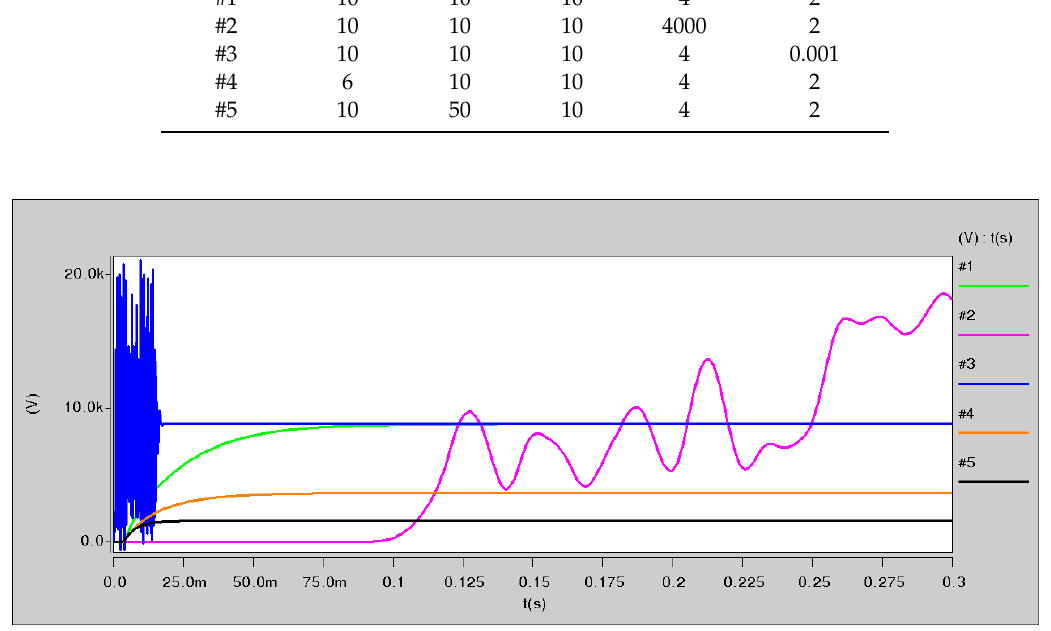
Figure 12. The voltage transient processes in five parameter sets.